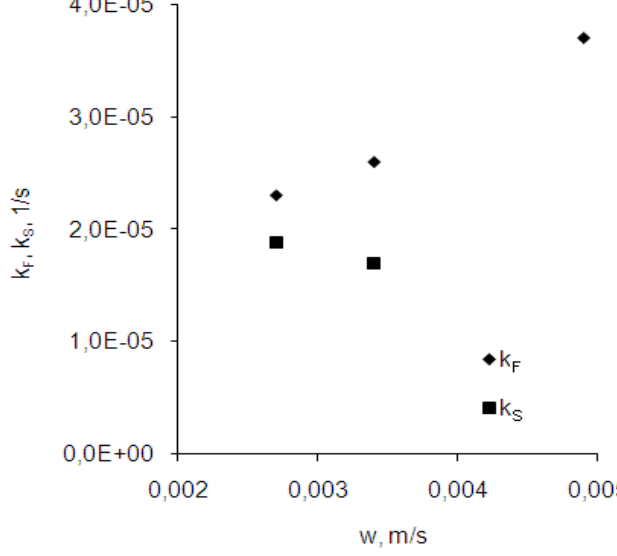
Figure 4. The pseudo-first-order apparent membrane entrance (k constants for different membrane flow velocity (initial chromium concentration C 5.8·10 -5 mol·m -3 ).